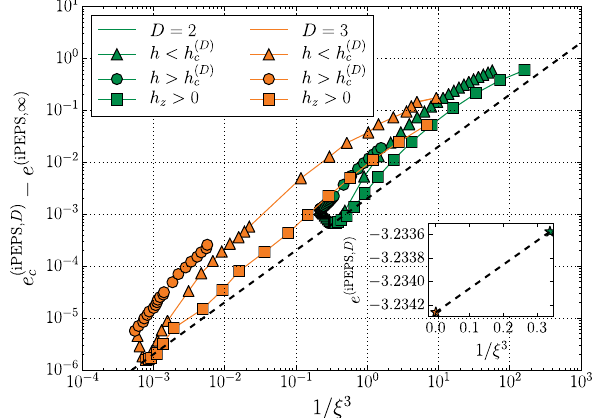
FIG. 5. Variational excess critical energy density Δ e c ¼ e ð iPEPS ;D Þ c − e ð iPEPS ; ∞ Þ c of transverse-field Ising iPEPS wave func- tions optimized for various ð h; h z Þ as a function of their 1 = ξ 3 . The variational excess energy density corroborates the advocated 1 = ξ 3 scaling. Inset: Fit according to Eq. (18), yielding e α ð iPEPS Þ 3 D Ising CFT in Eq.